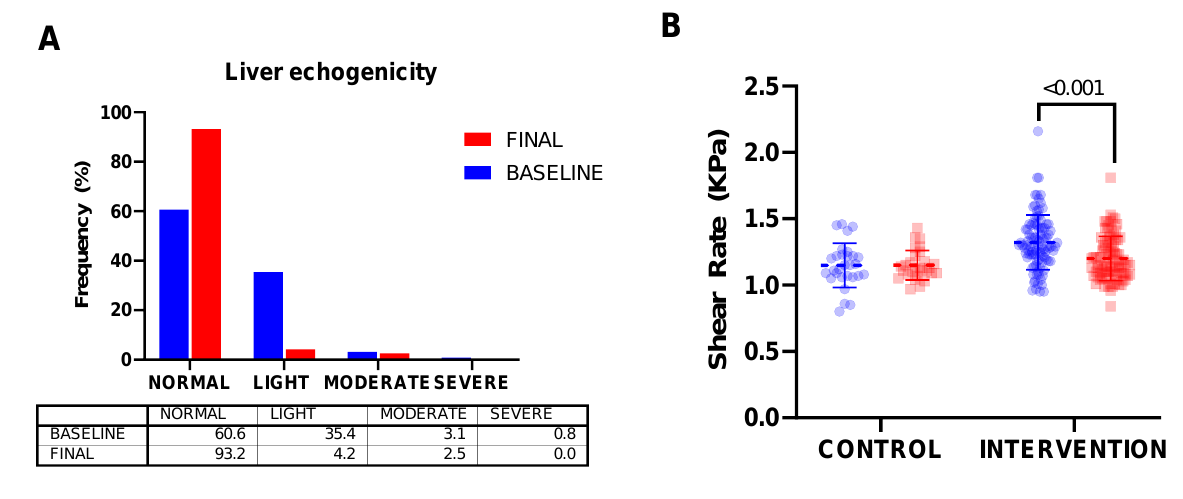
Figure 4. Effect of the intervention on liver echogenicity parameters. ( A ) Frequency distribution of children attending to their liver echogenicity status at baseline and at the end of the intervention. Specific data are detailed in the table below. ( B ) Changes on liver shear rate from baseline (blue dots) to the end of the intervention (red dots). The dashed line represents mean value and solid lines represent standard deviation. Statistically significant differences were analysed by a repeated measures ANOVA.